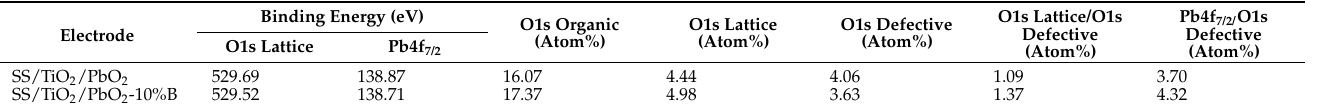
Table 1. XPS data of different chemical states of O and Pb elements on the surface of SS/TiO 2 /PbO 2 and SS/TiO 2 /PbO 2 -10%B electrodes.